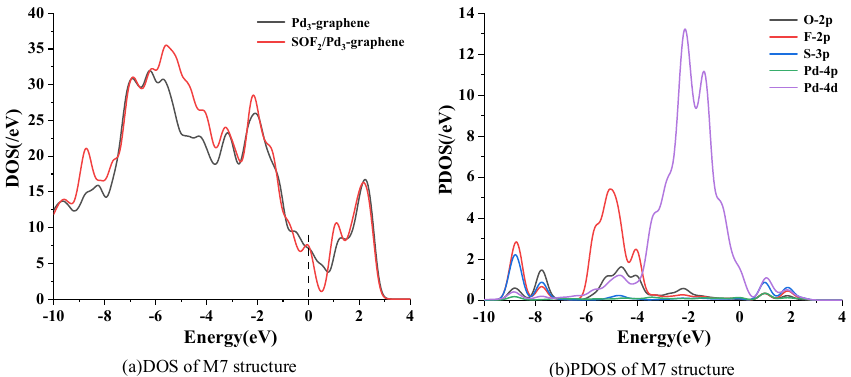
Figure 7. Density of states (DOS) and partial density of states (PDOS) of system M7. Dashed line represents the Fermi level.